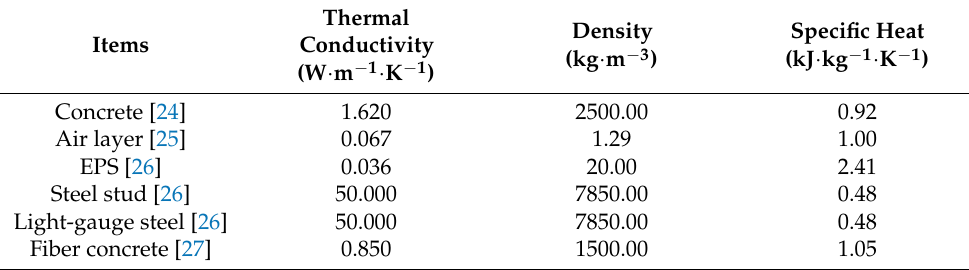
Table 5. Thermal property of different materials of the LAEWP.